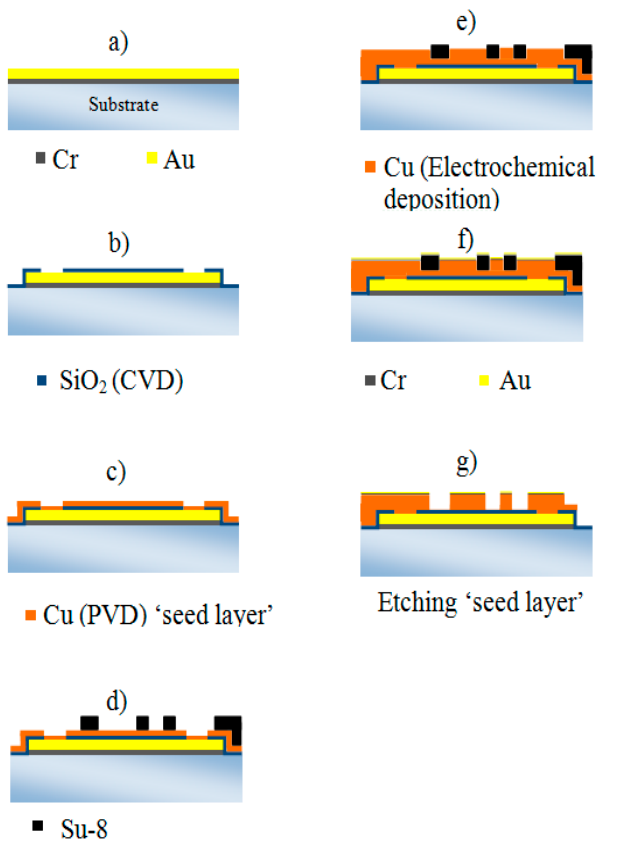
Figure 4. Fabrication process sequence of the